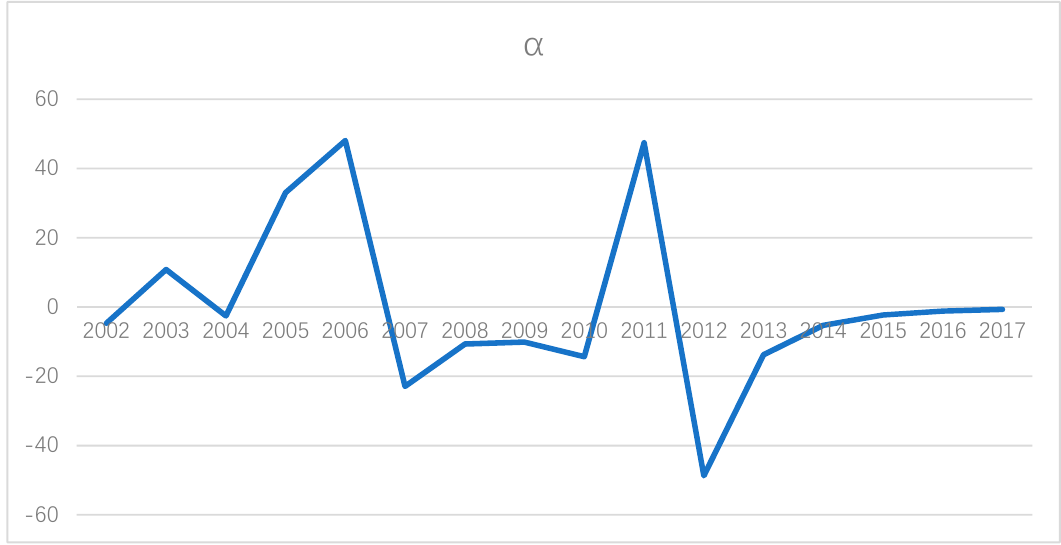
Figure 8. The dynamic coupling coordination degree of the socioeconomic and ecological environment benefits of land use.